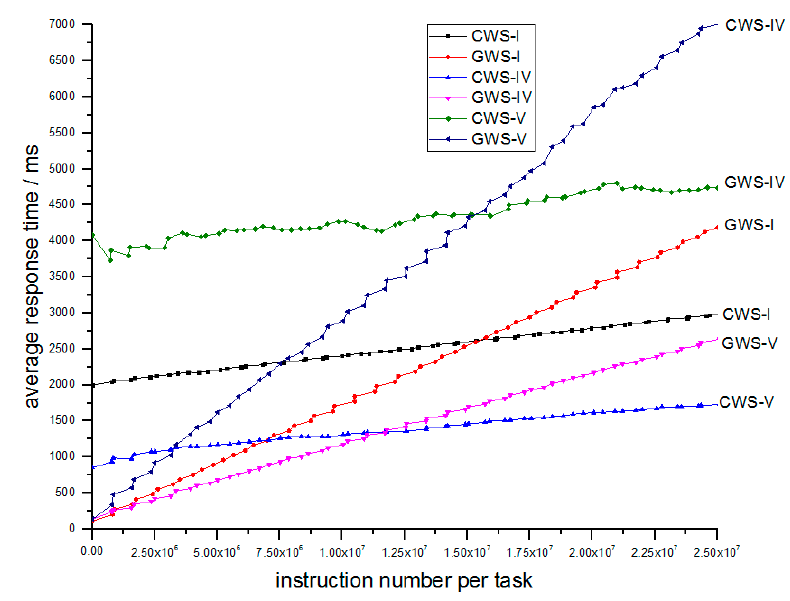
Figure 12. Relation of average response time and number of instructions per task between different process rates. Table 6. Parameters of Simulation V.